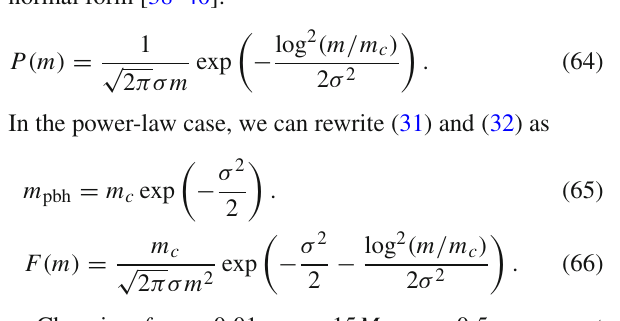
Fig. 7 Contouroftheratioofthetotalmergerratedensitytothesingle- merger one in the PBH mass plane in the case of f pbh = 0 . 01, q = 2 . 3 and M = 0 . 2 M (cid:2)